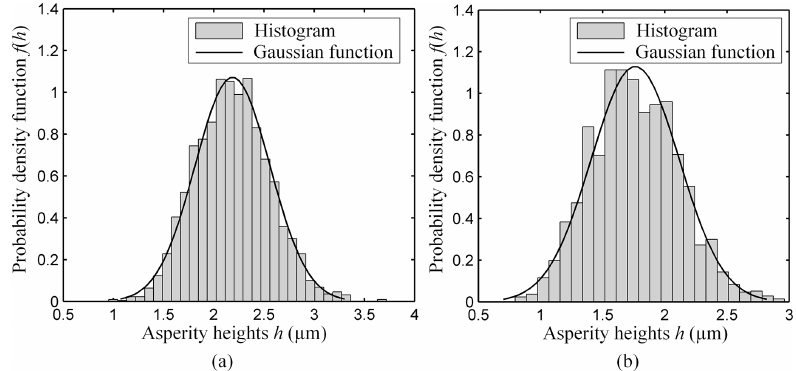
Figure 9. Statistical distribution of asperity heights of the measuring surface. (a) Turning specimen and (b) milling specimen.